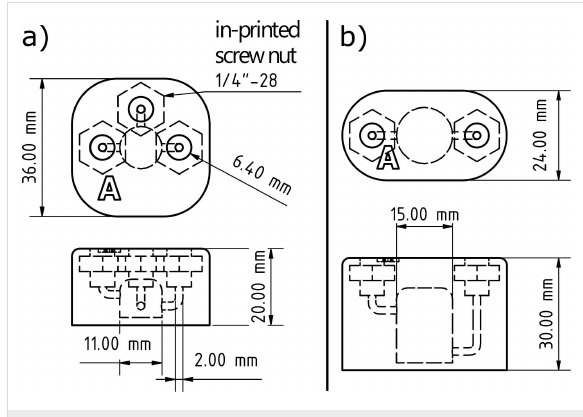
Figure 4: CAD drawing of two CSTR with three (a) and two inlets (b) with in-printed screw nuts 1/4’’ – 28 thread for flat bottom fittings.